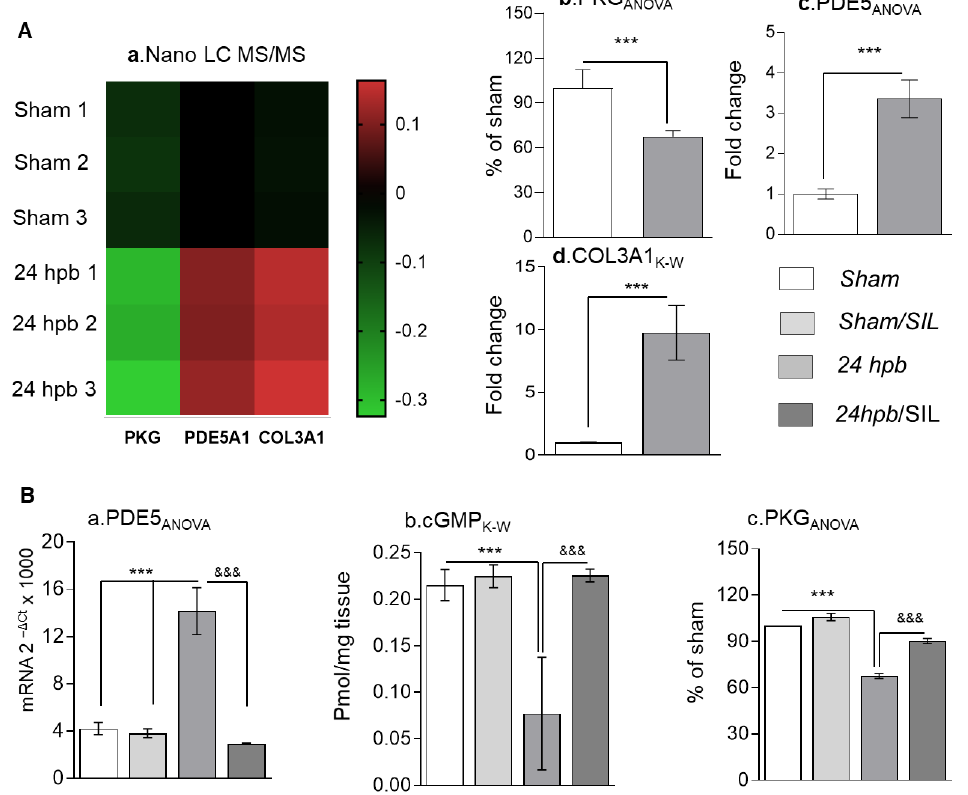
Figure 1. The importance of the PDE5A-cGMP-PKG pathway in cardiomyocytes after a burn. Sprague–Dawley rats were randomized to a 60% TBSA scald burn or sham procedure with standard resuscitation with / without sildenafil (SIL). Heart tissues and blood were harvested at 24 h post burn (24 hpb ± SIL). ( A ) Representative LC MS / MS heat map; green color indicates down-regulated proteins, black color indicates unchanged proteins and red indicates up-regulated proteins (A,a). Corresponding expression levels of PKG (A,b), PDE5A (A,c.) and COL3A1 (A,d). ( B ) Myocardial levels of PDE5 mRNA by qRT-PCR (panel a), cyclic GMP (cGMP) protein levels in heart tissue (panel b) and PKG activity in heart tissue (panel d). Data are presented as mean value ± SD, shown as * (24 hpb vs. matched sham control) or & (24 hpb vs. 24 hpb / SIL), and presented as *** , &&& p < 0.001 (n = ≥ 6 per